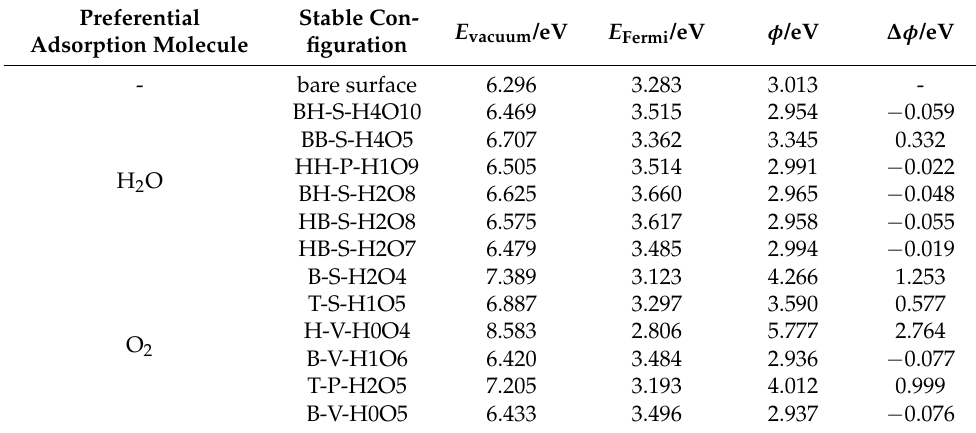
Table 4. Changes in the surface work function of all stable adsorption configurations after optimiza- tion of co-adsorption of O 2 and H 2 O on the δ -Pu (100) surface. Stable Con- E vacuum /eV E Fermi /eV φ figuration